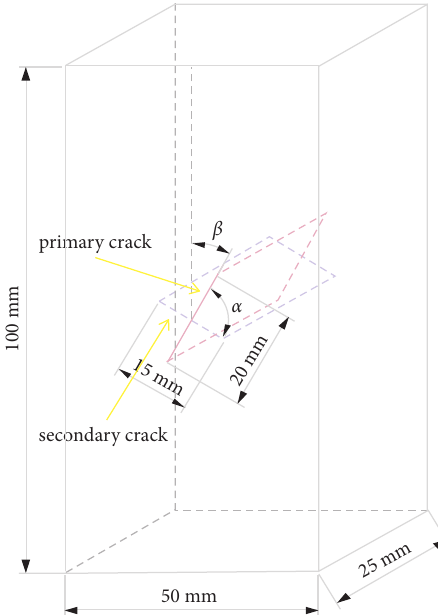
Figure 1: Illustration of the granite sample with crossed cracks.